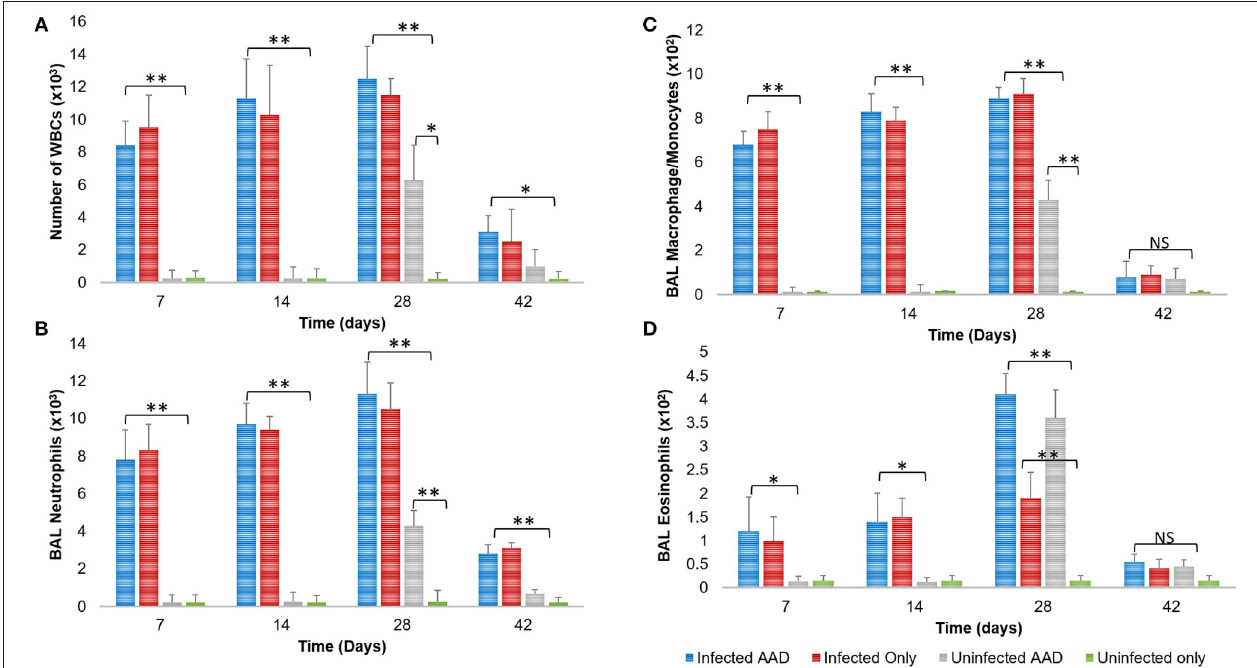
FIGURE 6 | BAL cellular response to infection and AAD Induction . Infected groups with active infections had elevated levels of total WBCs, neutrophils, and macrophages compared to all other groups, which peaked on day 28 post infection (A–C) . Animals displayed significantly elevated numbers of BAL eosinophils on day 28 when AAD was fully induced (D) . All cell counts decreased to uninfected levels after infections were cleared and AAD subsided. N = 5 animals for each treatment group. * P < 0.05, ** P < 0.0001. P -value. An independent-sample T -test was performed for uninfected controls compared to infected animals; NS represents a p -value that is not significant. Results are representative of 2 independent